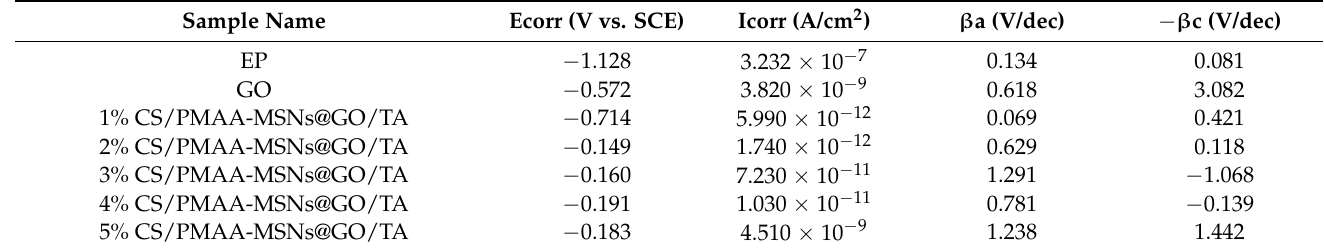
Table 3. Corrosion potential (E corr ), corrosion − current density (I corr ) of different samples after 960 h of immersion in 3.5 wt% NaCl aqueous solution.